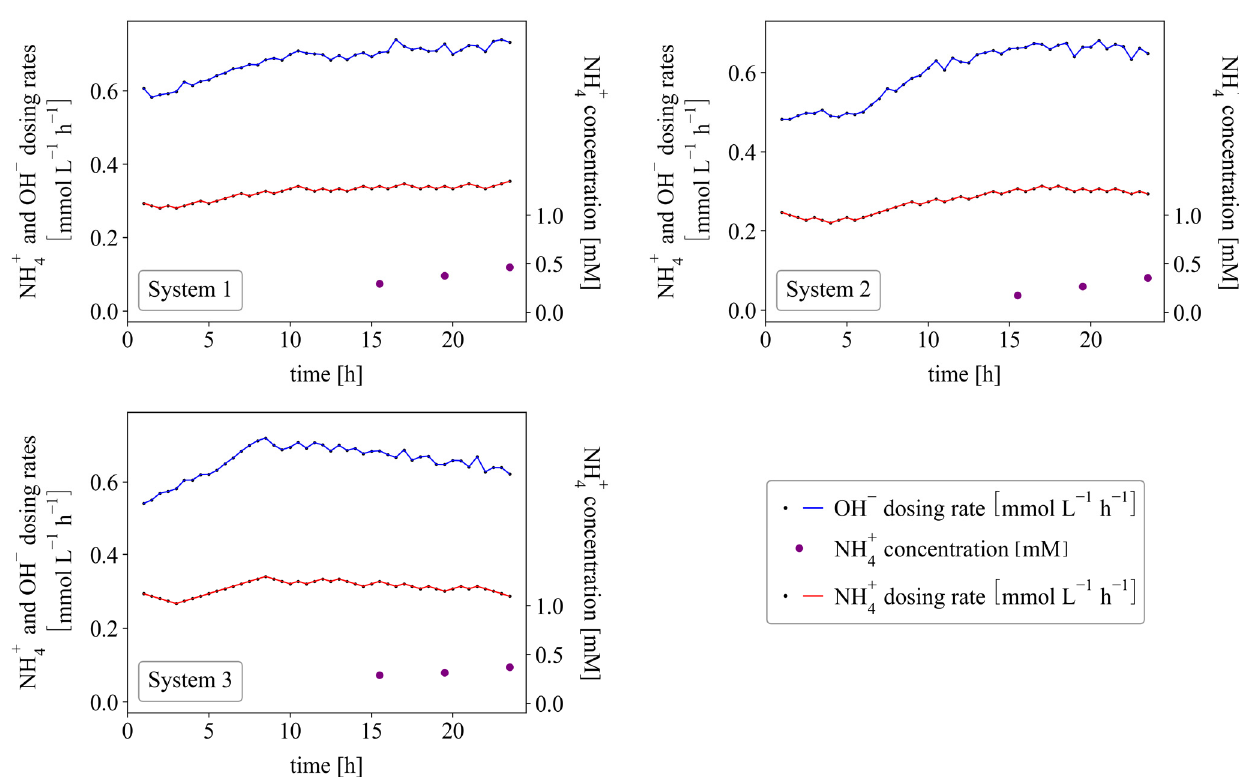
Figure 6. Results from the control strategy shown in Figure 5, employed in a fed-batch system. Hydroxide dosing rates are shown as blue lines and the ammonium dosing rates are show as red lines. The ammonium concentrations in solution were measured and shown as purple dots. “Spot checks” were done for nitrite of which none was measured (<0.001 mM).